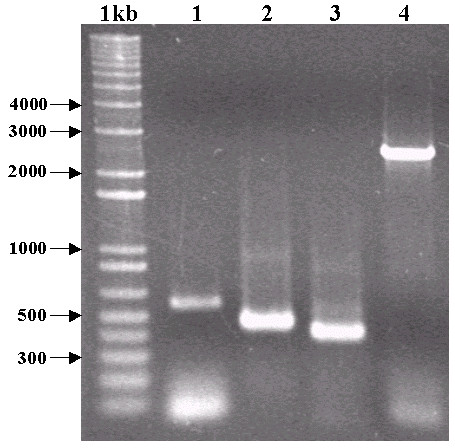
PCR amplification products from transgenic plants and calluses. Lane 1, α-interferon in transgenic calluses from Siberian ginseng; lane 2, Core epitope of PEDV; lane 3, LTB; lane 4, A plus B subunits of Helicobacter pylori urease. 1 kb, DNA molecular weight ladder.